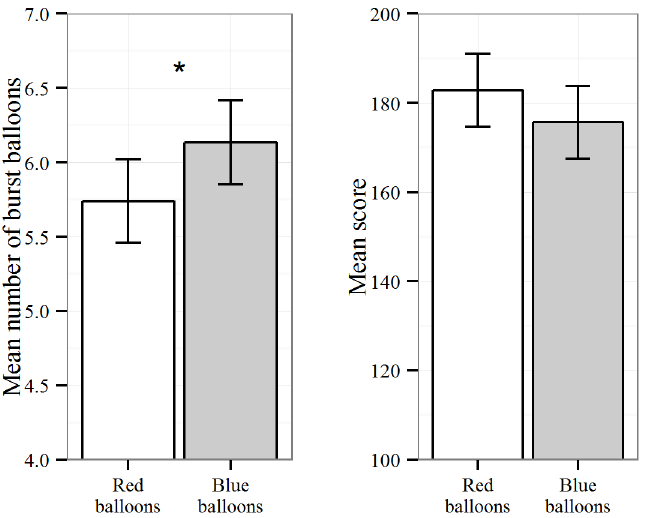
Fig 3. Number of burst balloons and total scores by balloon color (with 95% confidence